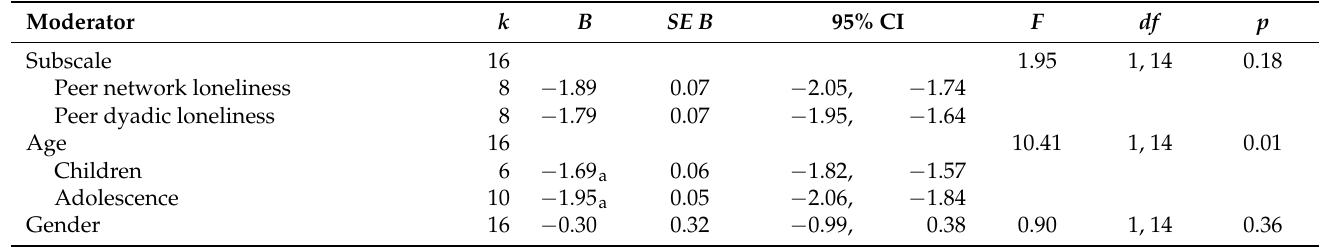
Table A6. Separate Regression Analyses for the Moderators Predicting Reliability Scores of the Peer Network and Dyadic Loneliness Scale